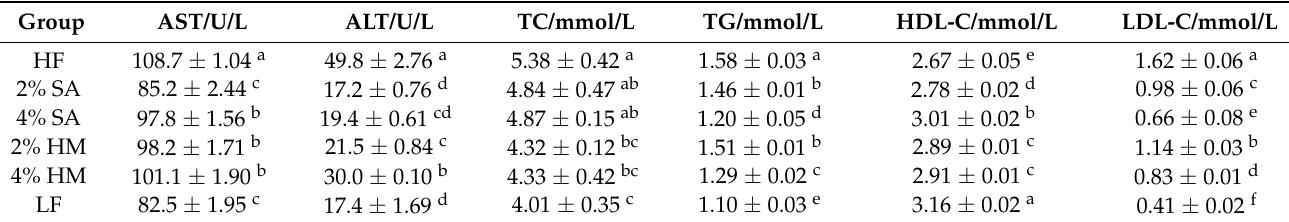
Table 2. Effects of phospholipids on serum indicators of high fat mice.